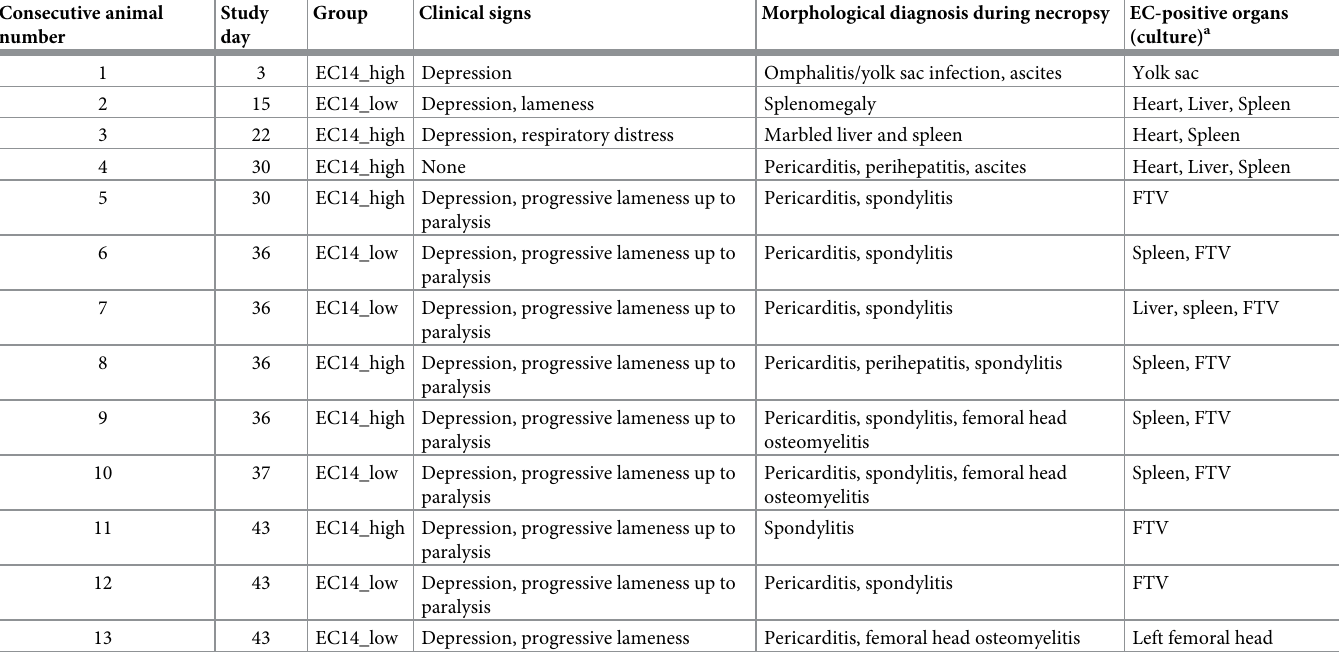
Table 1. EC-positive euthanized or dead birds at irregular